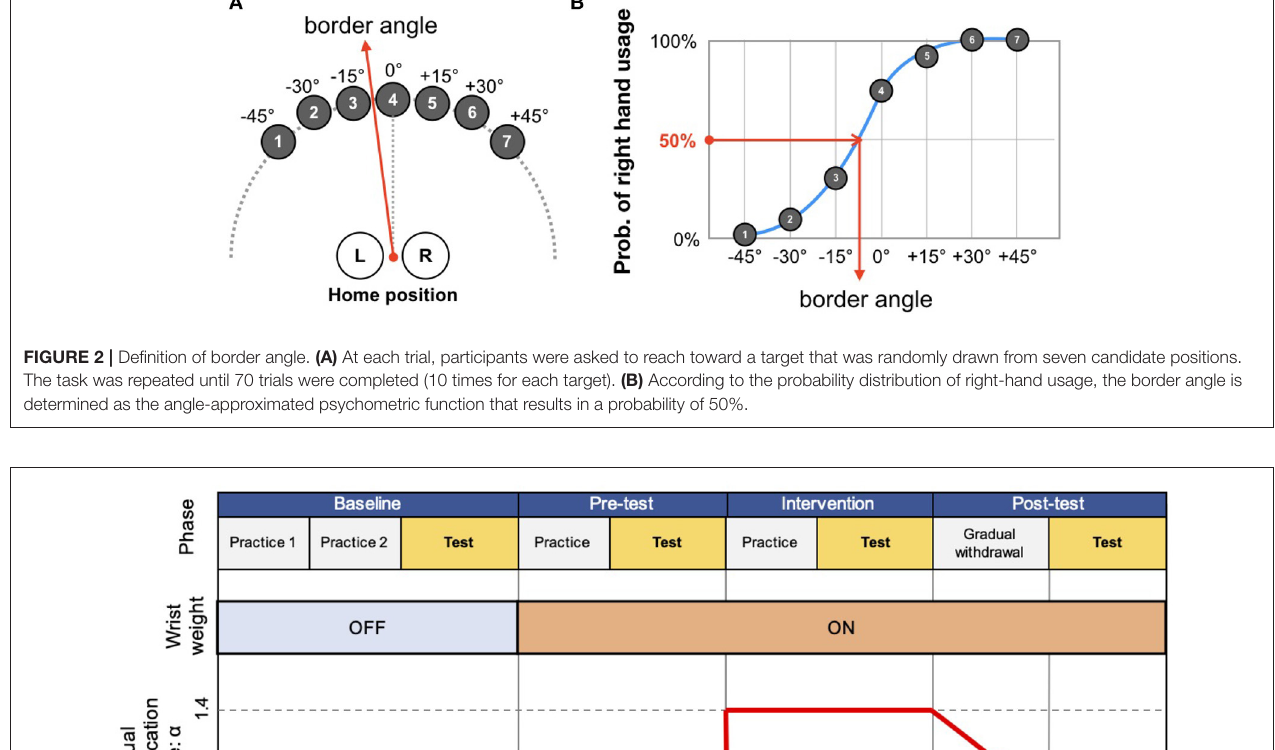
For further analysis, we conducted paired comparisons of the border angle distributions in each phase. The Shapiro-Wilk test was used to check the normality of the distribution, and the Wilcoxon signed-rank test was applied to